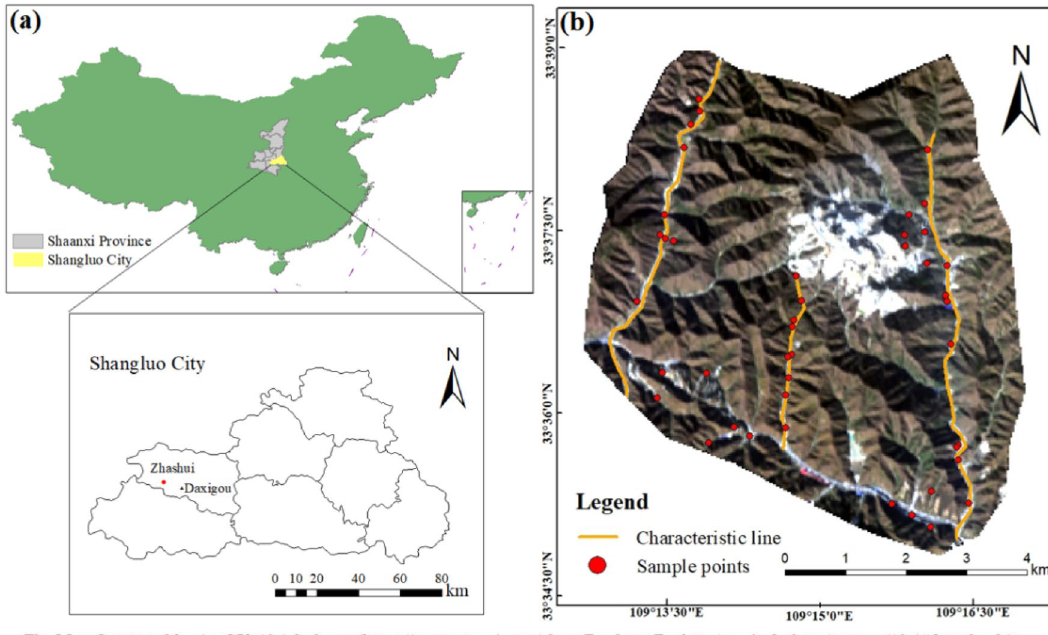
Figure 1. Maps showing ( a ) the location of the Daxigou mining area (enlarged map of Shangluo City) and ( b ) the distribution of sampling sites in a Landsat 8 image involving the spectral bands B4, B3 and